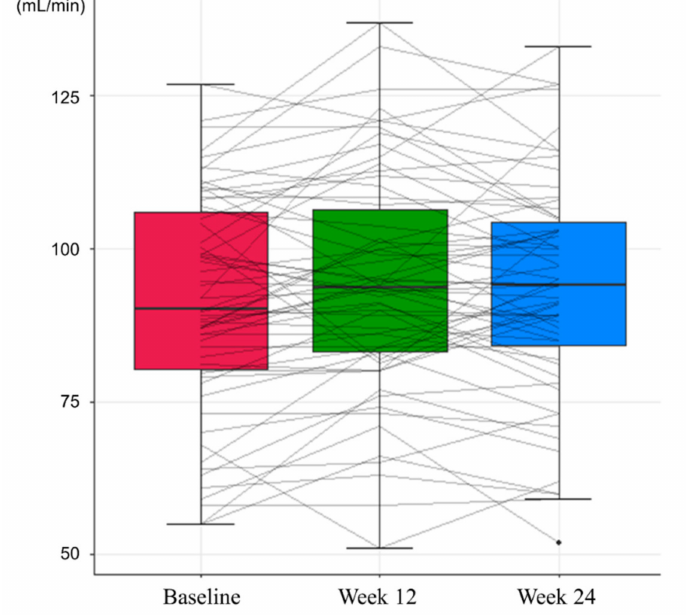
Figure 3. Changes in estimated glomerular filtration rates during the study